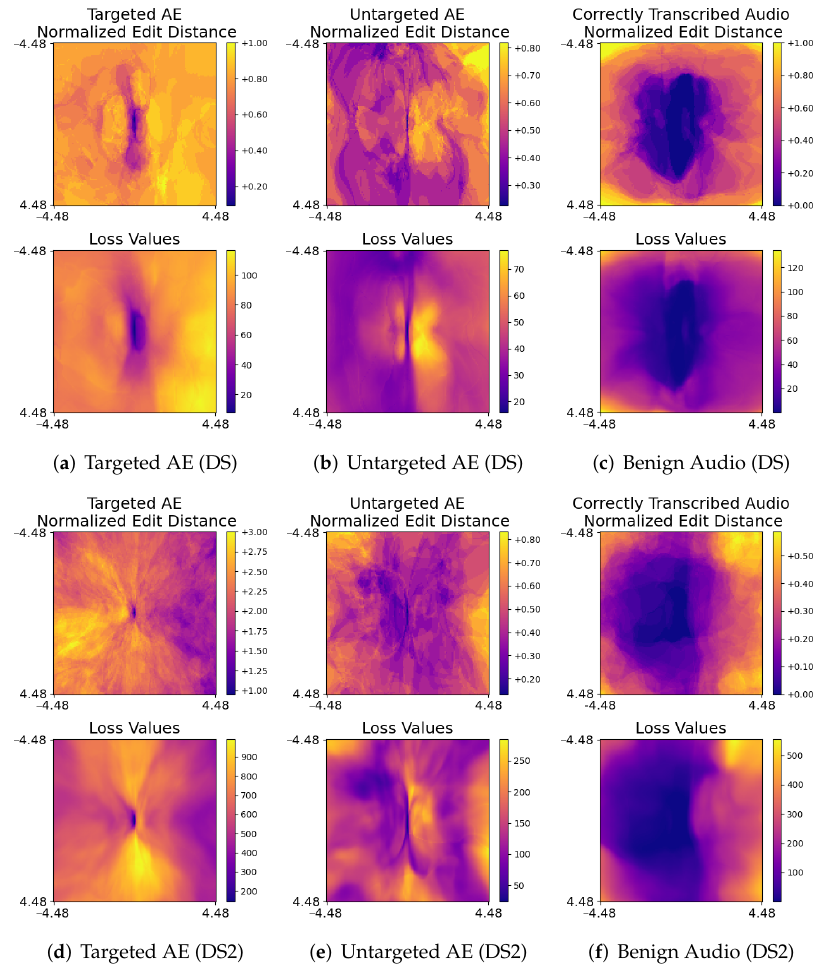
Figure 3. Heat maps of loss function values and normalized edit distances regarding different audio AEs and benign audio for DeepSpeech (DS) and DeepSpeech2 (DS2), respectively. Changes in loss function values and normalized edit distances of targeted and untargeted audio AEs are clearly different from benign